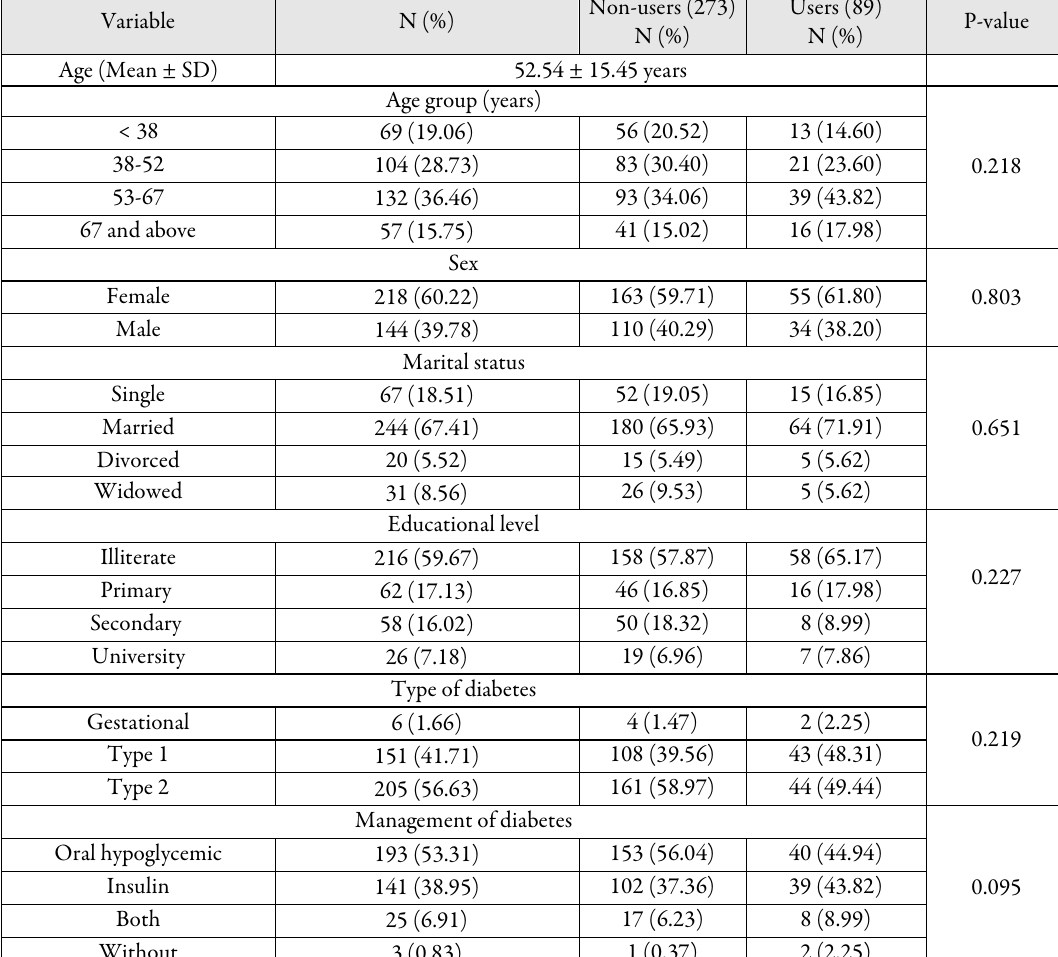
Table 1. Socio-demographic characteristics of